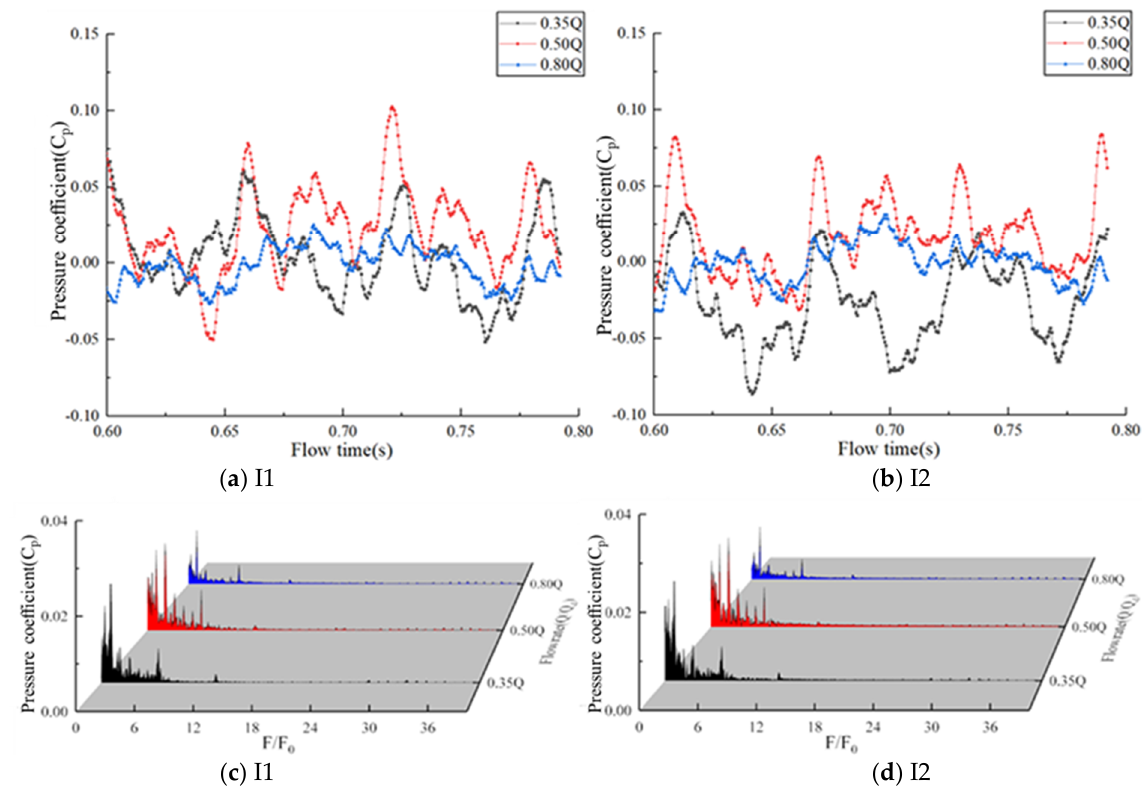
=8   ) at the inlet of impeller. Figure 14. Pressure pulsation of scheme A ( ∆ β = 8 ◦ ) at the inlet of 1 1